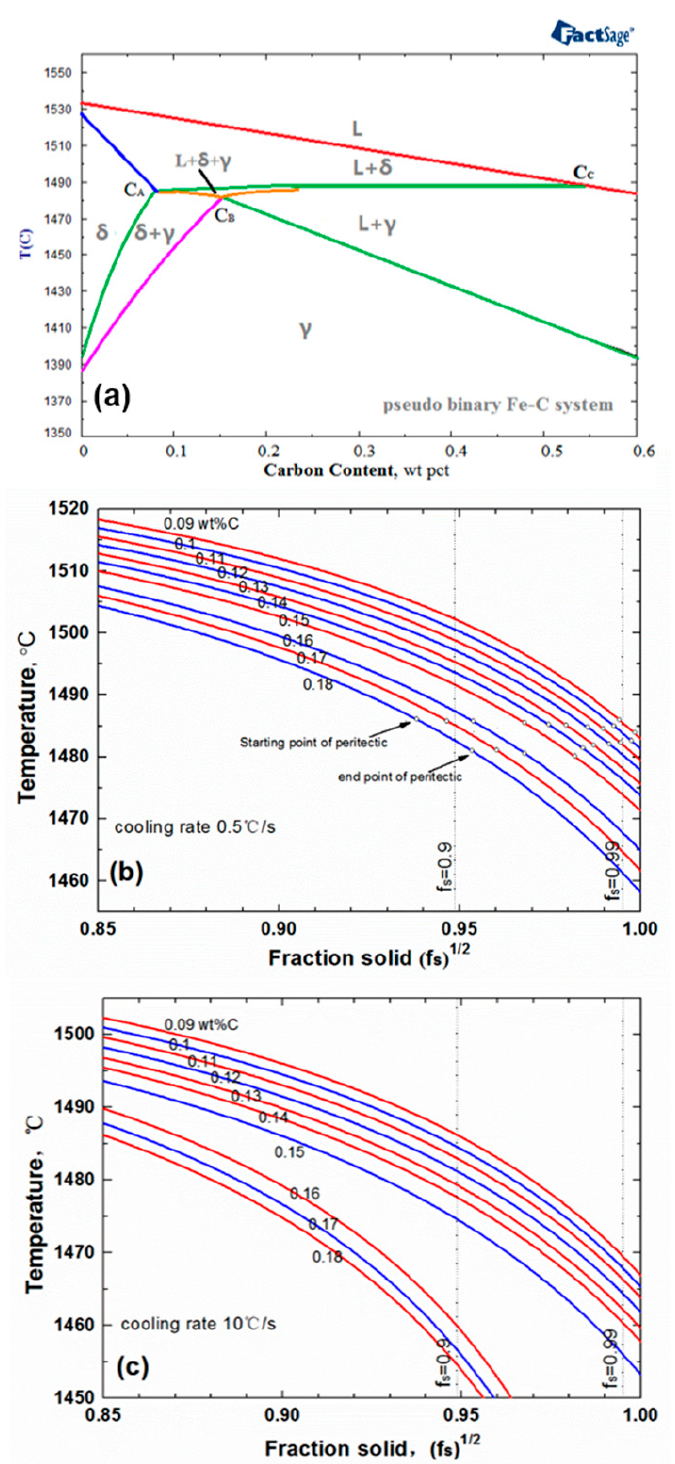
Figure 3. ( a ) The pseudo-binary phase diagram of Fe-C alloy; ( b ) the calculation of T − (f s ) 1 / 2 curve at 0.5 ◦ C / s; ( c ) the calculation of T − (f s ) 1 / 2 curve at 10 ◦ C /s. The steepness |d T /d( f s ) 1/2 | of the alloy is plotted against the carbon content under three cooling